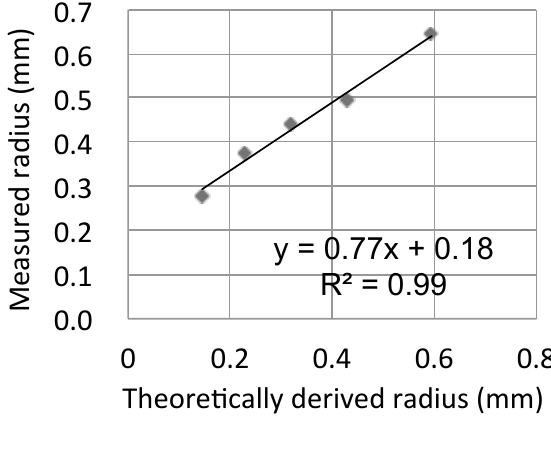
Figure 7. Relation between measured and theoretically derived radius of curvature of an individual glass